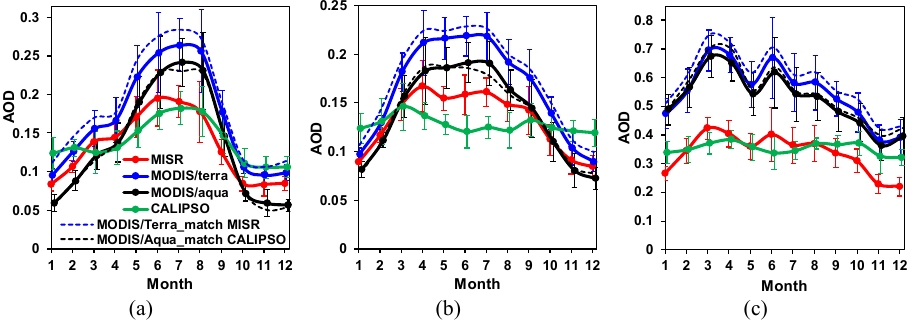
Figure 2. Monthly mean AOD observed by MISR, MODIS/Terra, MODIS/Aqua, and CALIPSO during 2007–2016 in (a) EUS, (b) WEU, and (c) ECC. For CALIPSO, only clear-sky daytime profiles are averaged in order to be consistent with the MISR and MODIS products. “MODIS/Terra_match MISR” is a sensitivity case in which the monthly mean AOD of MODIS/Terra is calculated using only the days when MISR overpasses, and “MODIS/Aqua_match CALIPSO” is a case in which the monthly mean AOD of MODIS/Aqua is calculated using only the overpassing days of CALIPSO. The error bars denote the standard deviation of the monthly mean AOD values obtained over all years. Note the different scales on the y axes of the